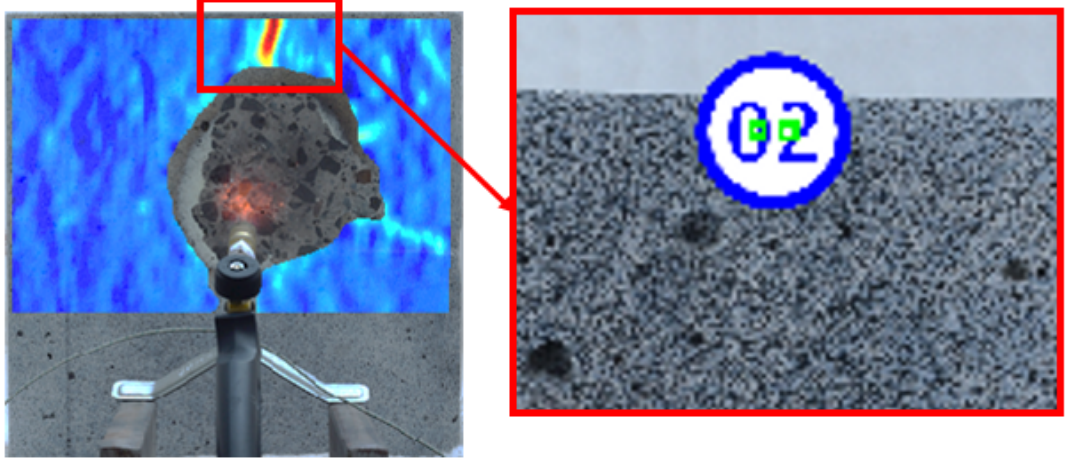
Figure 13. Virtual extensometer used for crack width measurement.